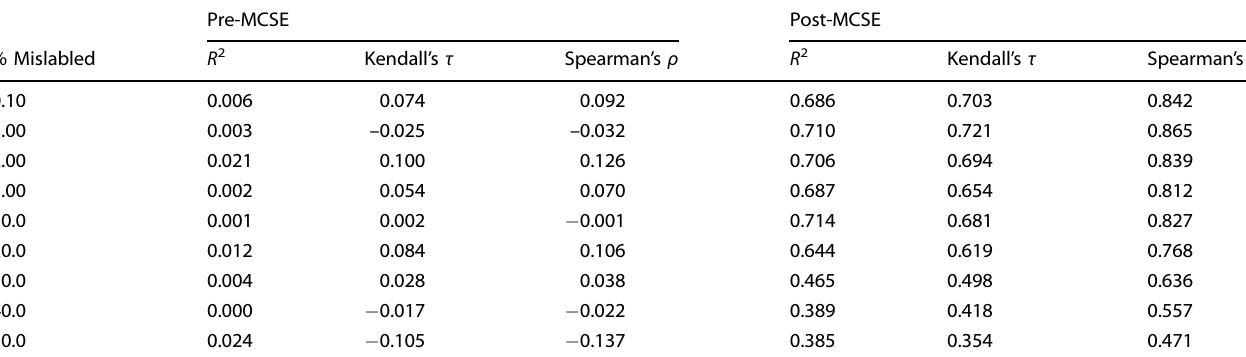
Table 3. Correlation between test area-under-the-curve and sample size above and below auto-encoder loss in fl ection points for with varying levels of label